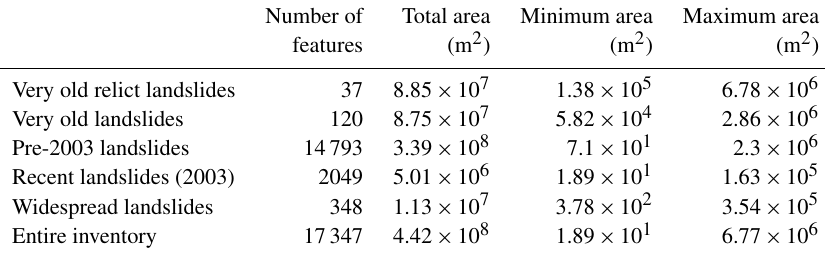
Table 1. Descriptive statistics of landslides by relative